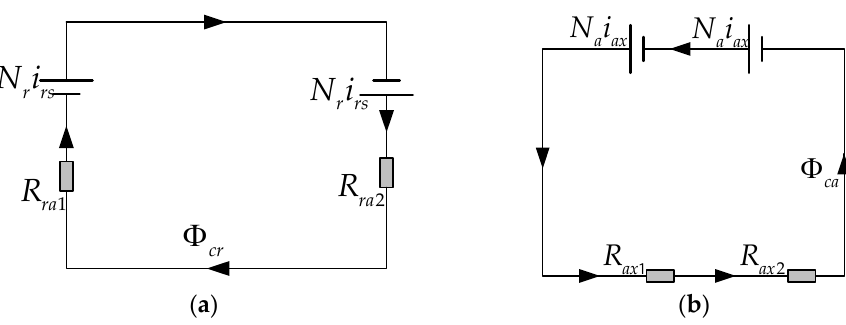
Figure 6. Equivalent magnetic circuit model of control magnetic field. ( a ) The equivalent magnetic circuit model of the radial active control circuit; ( b ) the equivalent magnetic circuit model of the axial active control circuit.